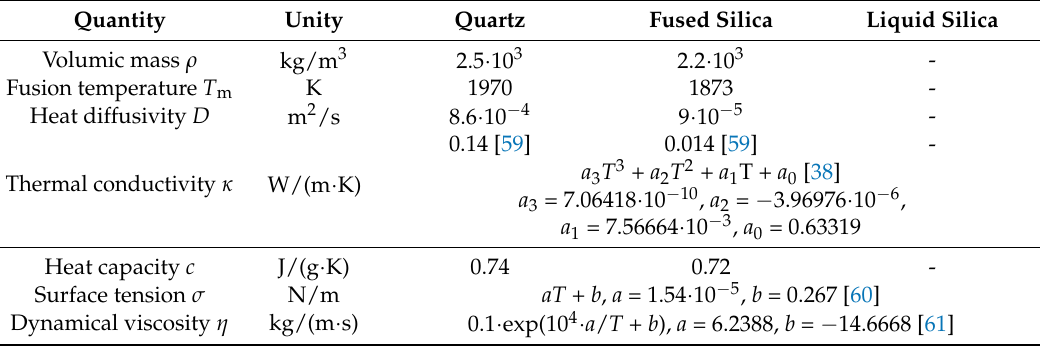
Table A1. Thermophysical properties of quartz, fused silica, and liquid